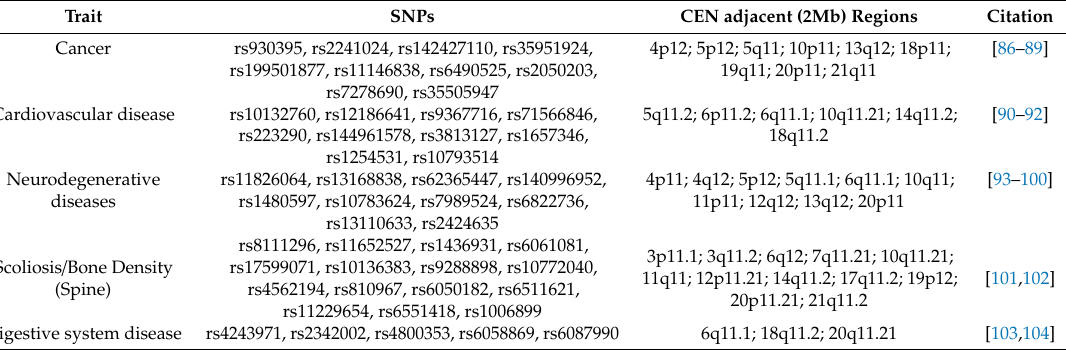
Table 1. Description of centromere-adjacent single nucleotide polymorphisms (SNPs) identified by published Genome-Wide Association Studies (GWAS), collected in the NHGRI-EBI GWAS Catalog published jointly by the National Human Genome Research Institute (NHGRI) and the European Bioinformatics Institute (EMBL-EBI) [80]. SNPs are included if found within a two-megabase window of an alpha satellite reference model (GRCh38) and do not overlap with annotated genes or segmental duplication).